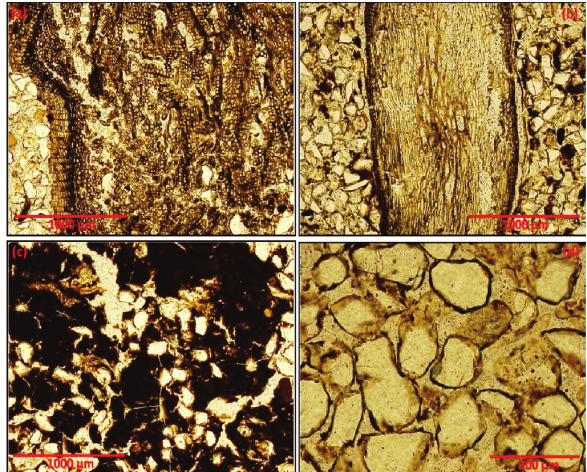
Figura 6. Fotomicrografias dos horizontes Bhsj1 e Bhsj2 do perfil J14, mostrando: (a) e (b) resíduos vegetais que são abundantes nos horizontes Bhsj1 (a) e Bhsj2 (b); (c) resíduos vegetais intimamente associados a constituintes finos, negros e orgânicos em avançado estádio de decomposição (horizonte Bhsj2); (d) detalhe dos revestimaentos e fábrica da porção superior do horizonte Bhsj1. Notar revestimentos orgânicos uniformes em cor e densidade distribuídos numa fábrica de distribuição g/f 2µm predominantemente quitônica, típicos de matéria orgânica iluvial e, portanto,